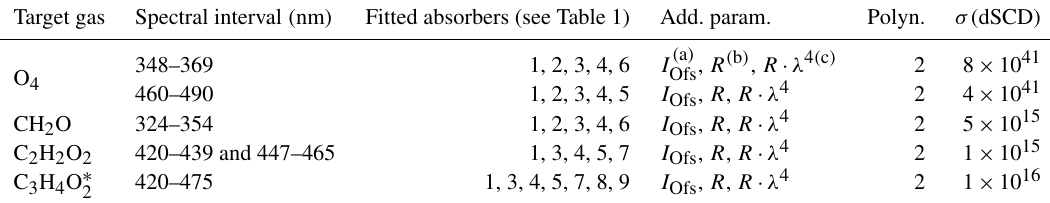
Table 1. Trace gas absorption cross sections used for the DOAS-based spectral retrieval. No. Absorber Temperature (K) Reference Uncertainty ( % ) O 4 273 O 3 203 O 3 273 Serdyuchenko et al. (2014) NO 2 273 Burrows et al. (1998) H 2 O 293 293 Chance and Orphal (2011) Meller et al. (1991) 223 Table 2. Details of the DOAS spectral analysis for the various trace gases. Target gas Spectral interval ( nm ) Fitted absorbers (see Table 1) Add.